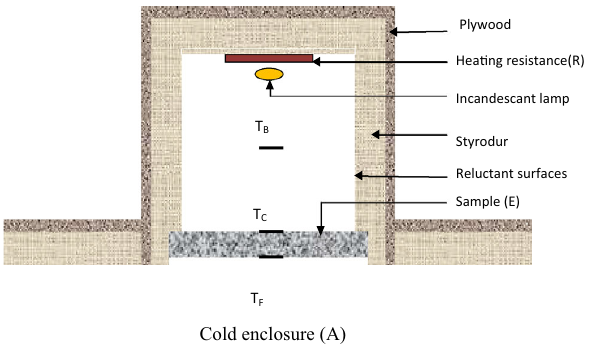
Fig. 3 Density variation with percentage of fiber for the